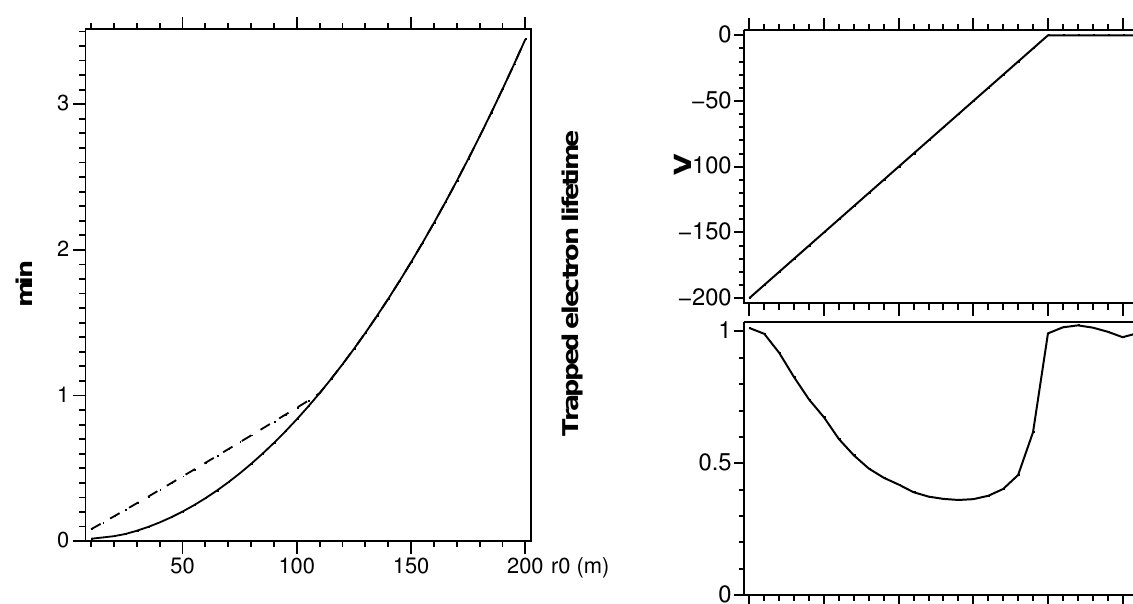
Fig. 10. Trapped electron lifetime (Eq. 23) as function of shielding distance r o for 20km (solid) and 100km (dashed) tethers.